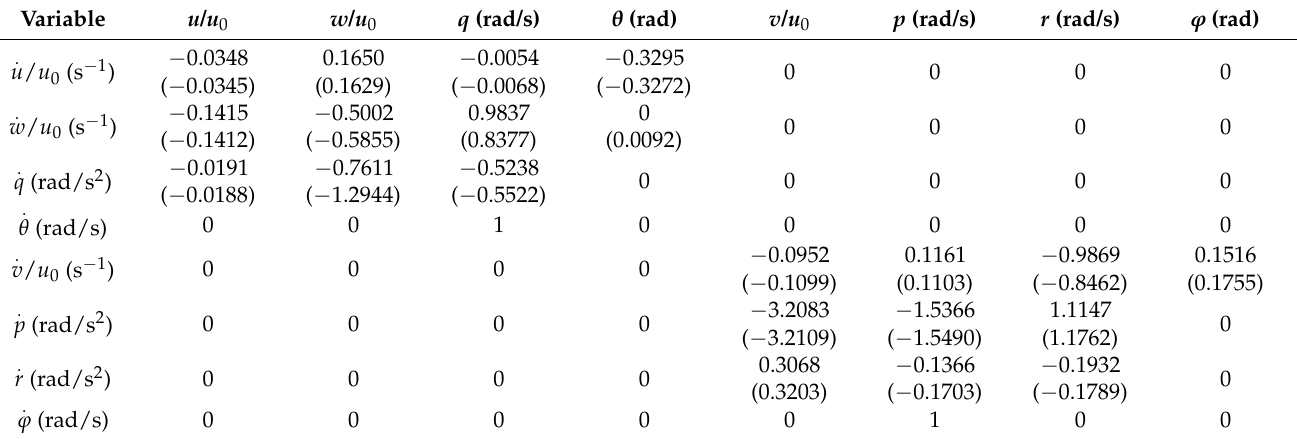
Table 16. CFD–RANS (extrapolated) 8 × 8 stability matrix for flight condition 9 in Tables 4 and